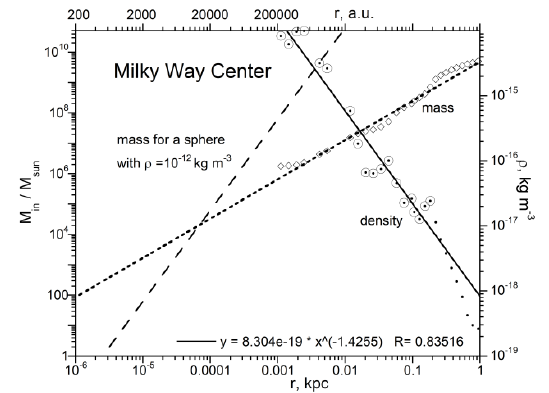
Figure 4. Expanded view of the Milky Way center. Mass and density are shown on left and right axes, respectively. The fit to ρ is for r < 0.2 kpc. Central mass is estimated by extrapolating the mass curve (dotted line) and by assuming a high density (dashed line). See Figure 3 for data sources.